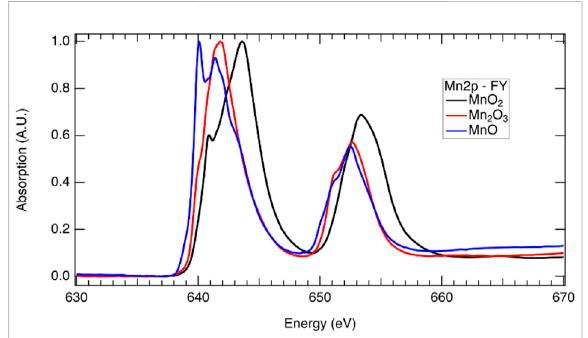
FIGURE 7 X-ray absorption spectra at the Mn 2p edge demonstrating theshift in energy associated with oxidation state which includes a sample that is predominately Mn 2+ from MnO (blue), Mn 3+ from Mn 2 O 3 , and Mn 4+ from MnO 2 (black). The L 3 edge is at approximately 640 eV, while the L 2 edge is at approximately 652 eV (see above for discussion on the L 2 and L 3 edges). Multiple peaks are present for all three samples in the L 3 and L 2 edges, indicating that the samples are not pure and have some contribution from other Mn oxidation